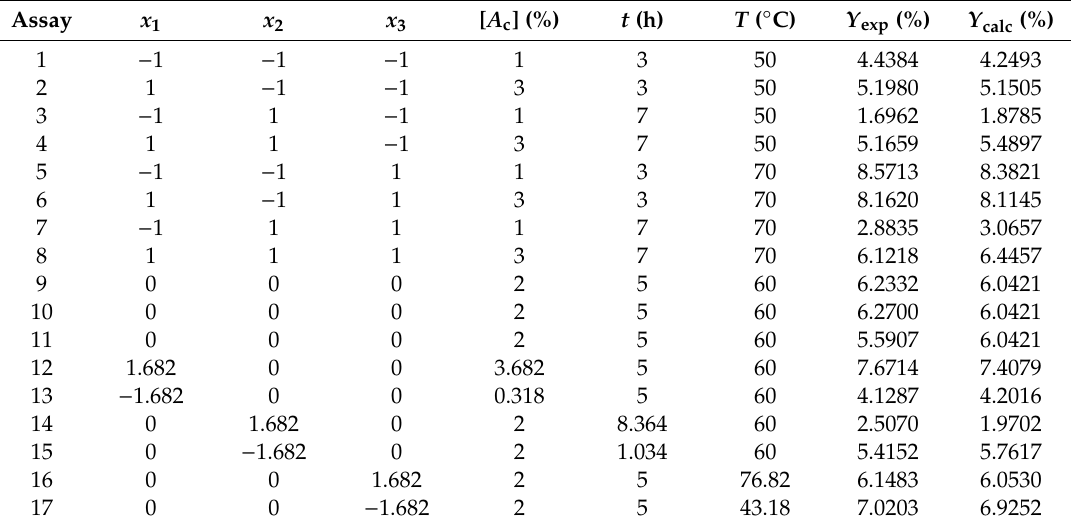
Table 4. Experimental design and the results of the collagen extraction process.